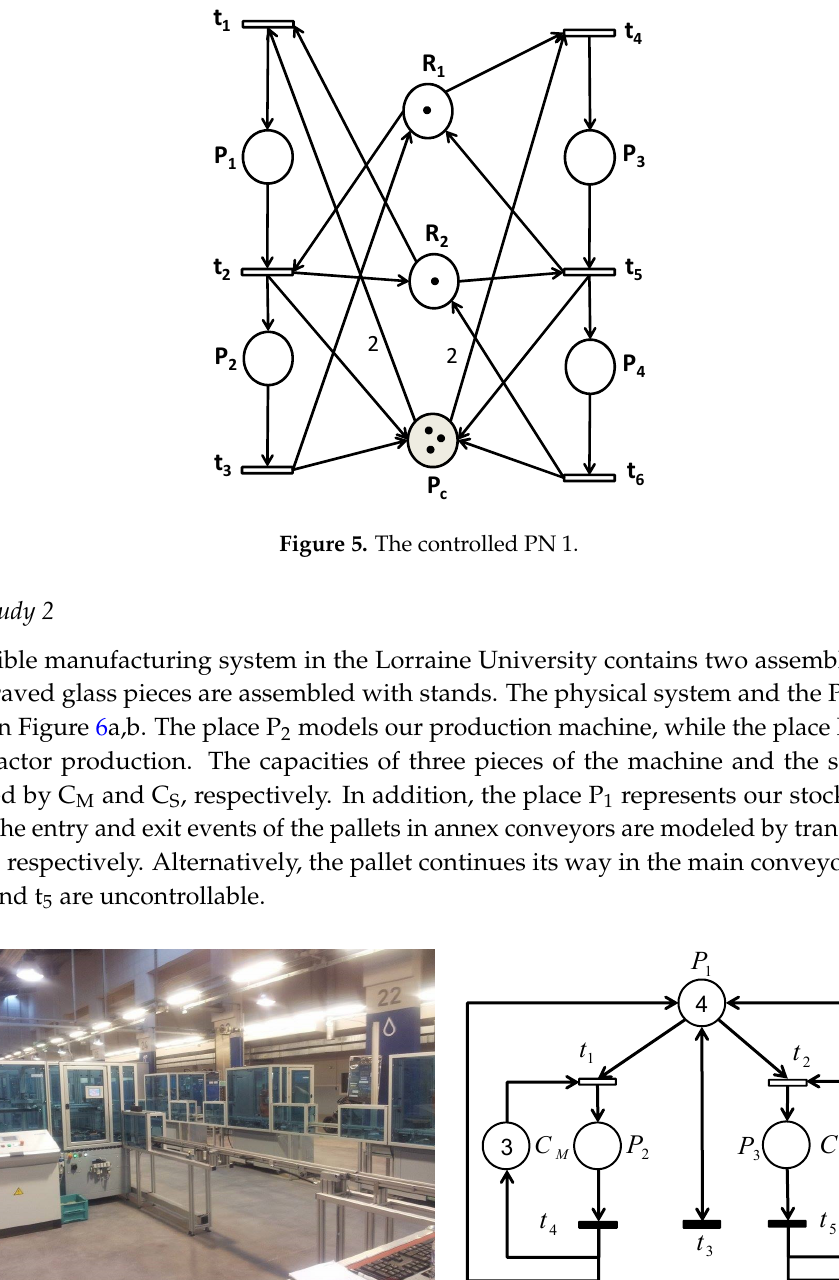
Figure 6. Flexible manufacturing system: ( a ) experimental environment; and ( b ) PN model.